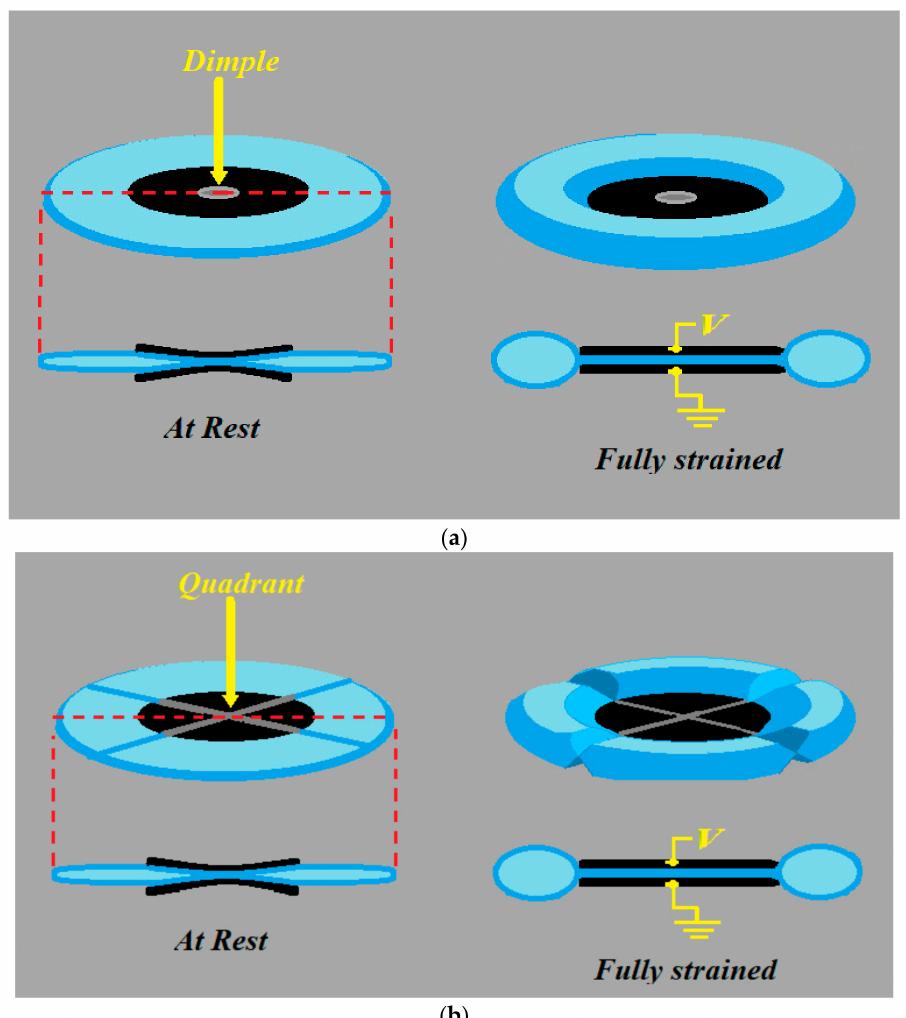
Figure 3. (Above) The design and operation of ( a ) the dimple and ( b ) quadrant mechanism with the zip mechanism [4].